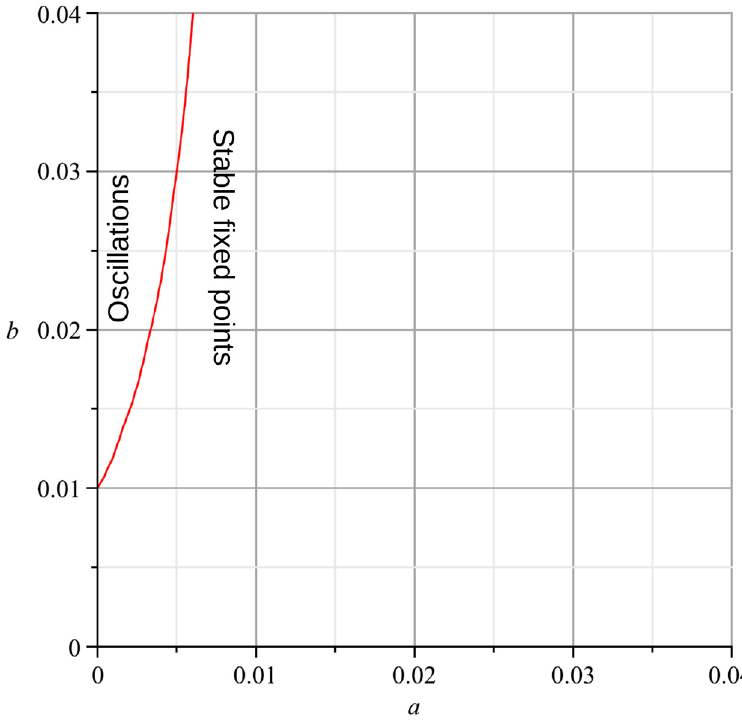
Fig 15. Linear stability analysis of the GM model. The curve shows where the real part of the first eigenvalue of the Jacobian matrix in the fix-point is zero in dependence of the parameters a (sigmaa) and b (mua).